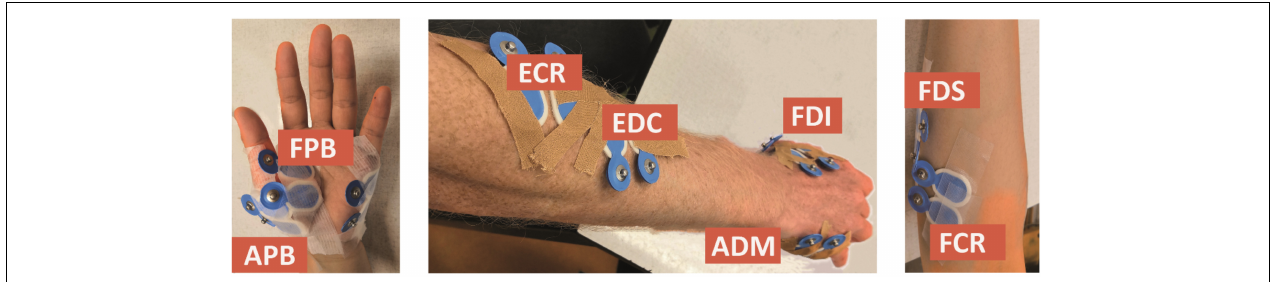
FIGURE 1 | Electrode placement for the first dorsal interosseous (FDI), abductor digiti minimi (ADM), abductor pollicis brevis (APB), flexor pollicis brevis (FPB), extensor digitorum communis (EDC), flexor digitorum superficialis (FDS), extensor carpi radialis (ECR), and flexor carpi radialis (FCR)